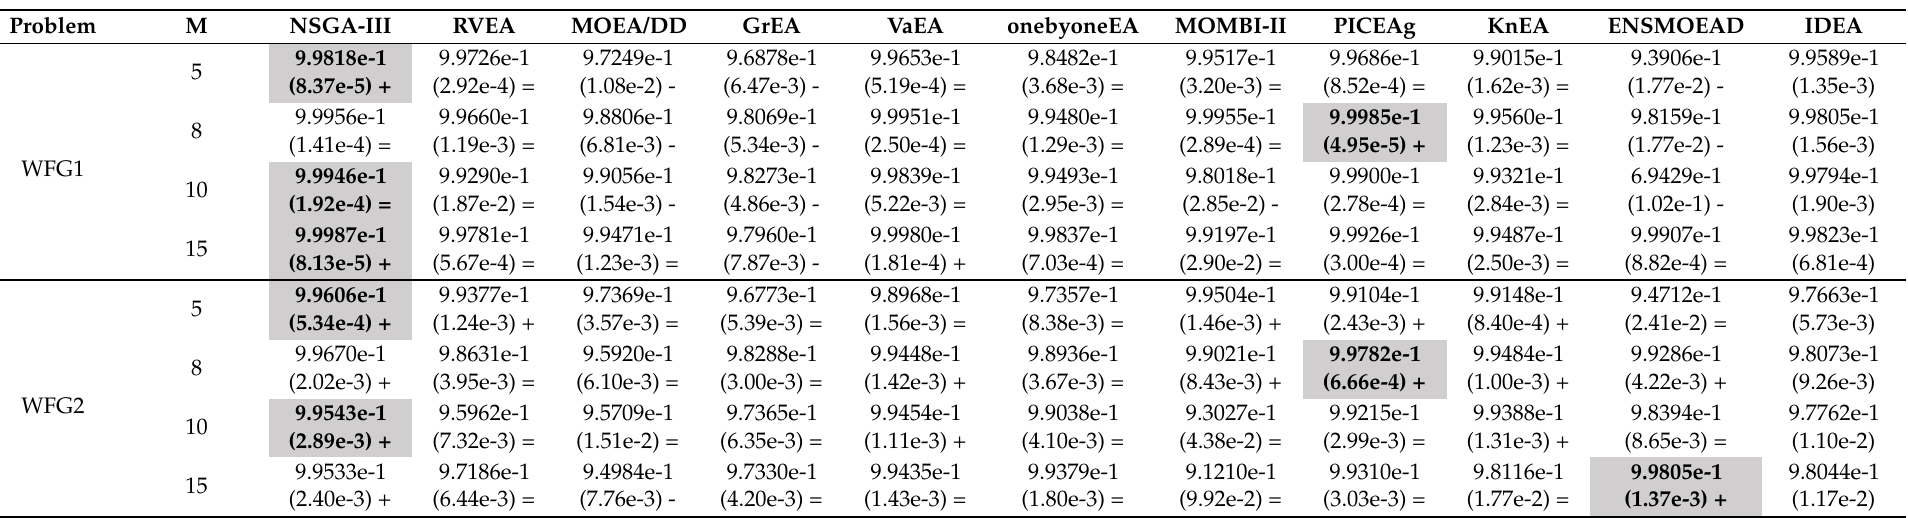
Table 6. The statistics of HV results (mean and standard deviation ) on irregular Pareto front